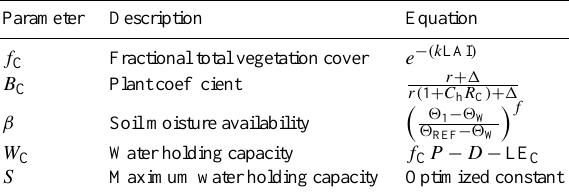
Table 3. Model parameters and equations for GNOAH, where k is Beer’s Law extinction coefficient, LAI is the leaf area index, r is the atmospheric resistance, R C is the stomatal resistance, C h is the surface exchange coefficient for heat and moisture, 2 1 is the soil moisture in the top soil layer at a given timestep, 2 W is the wilting point, 2 REF is the field capacity, and f is a scaling constant typically equal to 1 or 2. The change in water holding capacity is defined by P (precipitation), D (drainage) and LE C (in mass